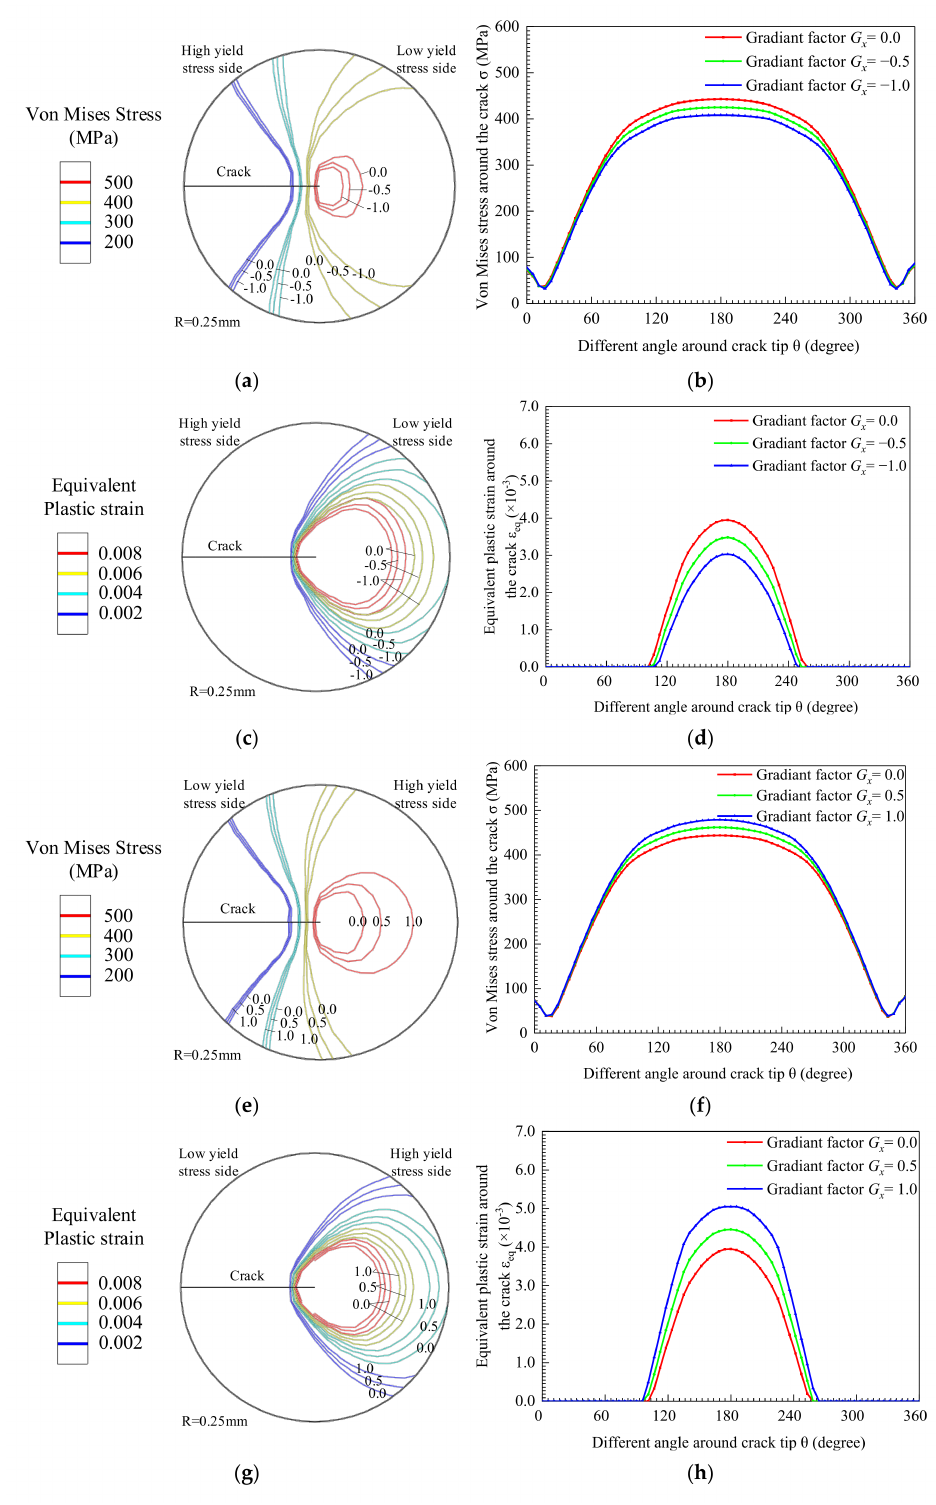
Figure 10. Crack tip mechanical field with crack parallel to the direction of yield strength change. ( a ) G x < 0 Von Mises stress contour, ( b ) Von Mises stress around crack tip, ( c ) Equivalent plastic strain contour and ( d ) Equivalent plastic strain around crack tip. ( e ) G x > 0 Von Mises stress contour, ( f ) Von Mises stress around crack tip, ( g ) Equivalent plastic strain contour and ( h ) Equivalent plastic strain around crack